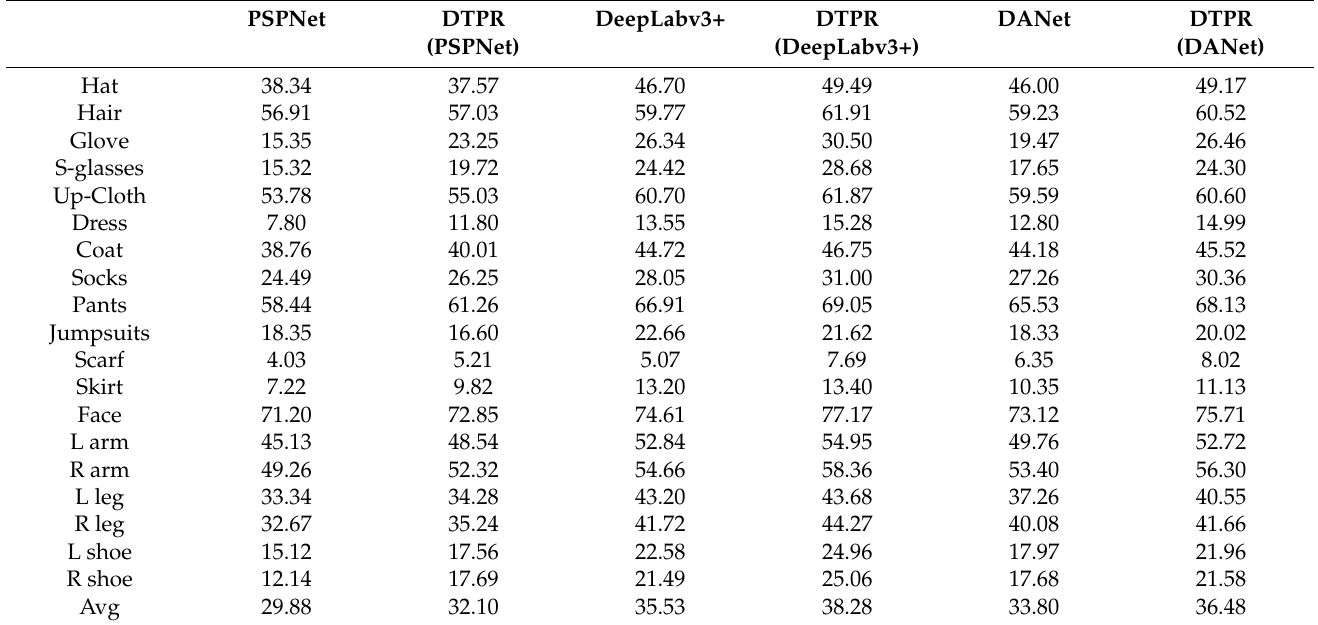
Table 8. Comparison of the SOTA model on the LIP validation